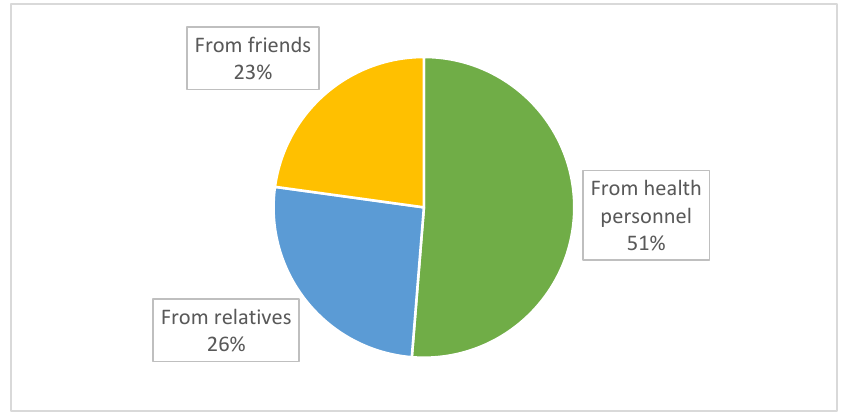
Figure 2. Sources of breastfeeding advice during pregnancy .